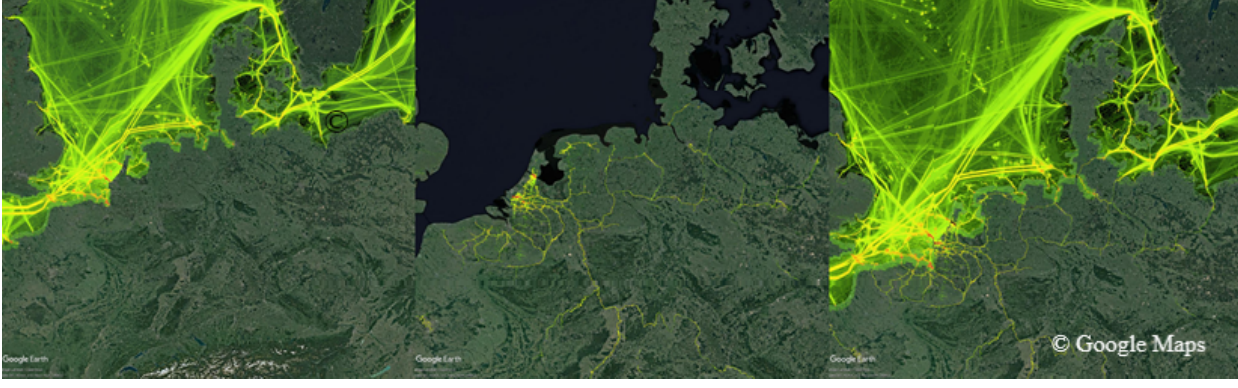
Figure 6. Example emission distribution of CO 2 for sea shipping (left), inland shipping (middle) and sum of both (right) for a specific region covering parts of the North Sea and Baltic Sea as well as inland waterways (example for 2016, at a high resolution of 1 / 60 ◦ × 1 / 120 ◦ ). Figures created using Google